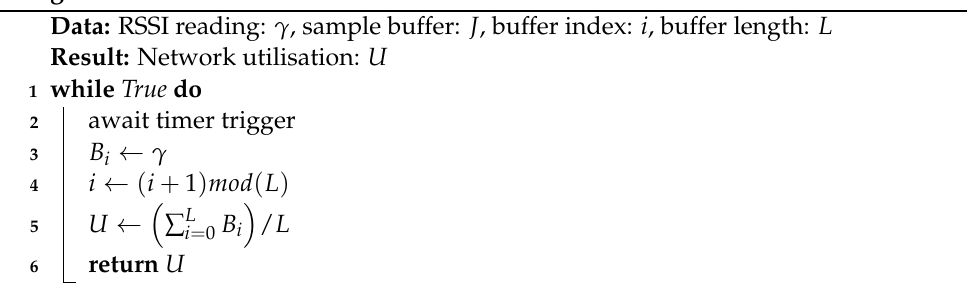
Algorithm 2: Base station: network